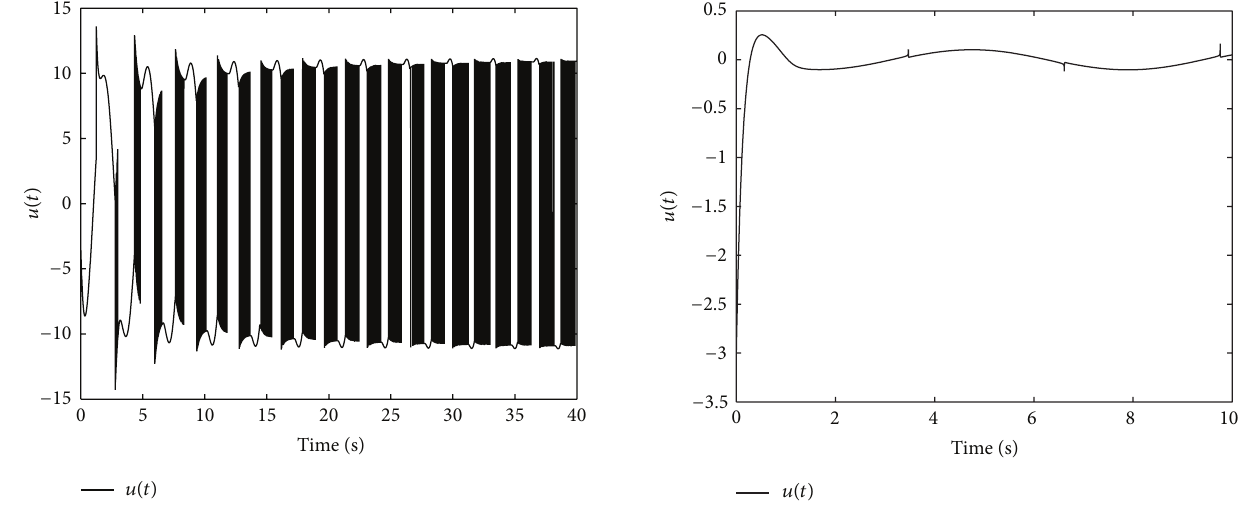
Figure 6: Time response 𝑢(𝑡) of system (1) with the control scheme